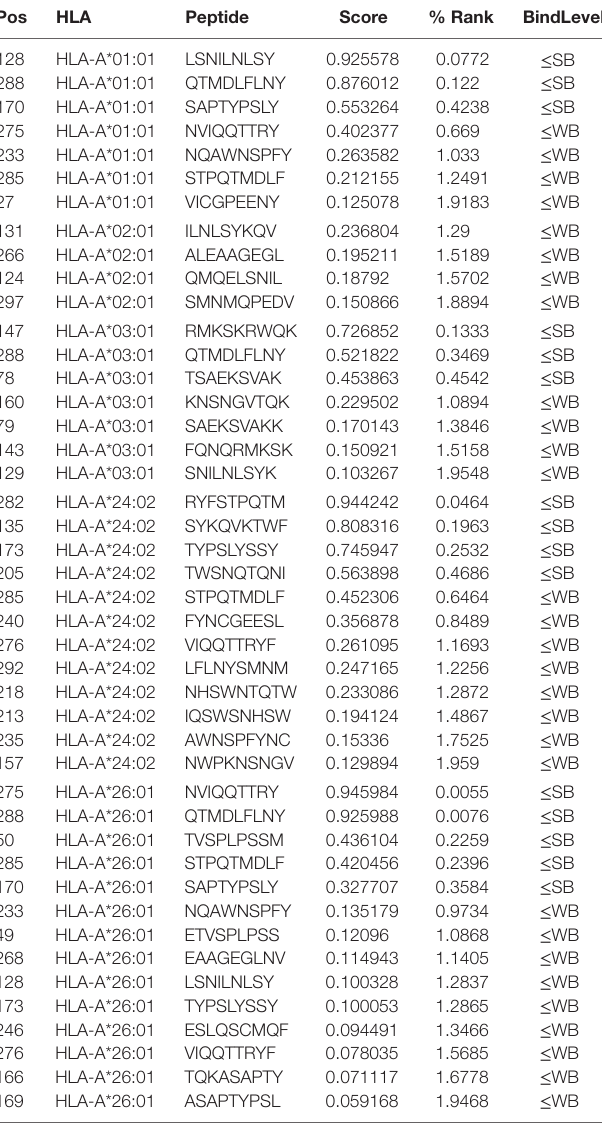
Peptide length 9; rank threshold for strong binding peptide 0.500; rank threshold for weak binding peptide 2.000; SB, strong binding; WB, weak binding; predicted peptides were generated using NetMHCpan Version 4.0